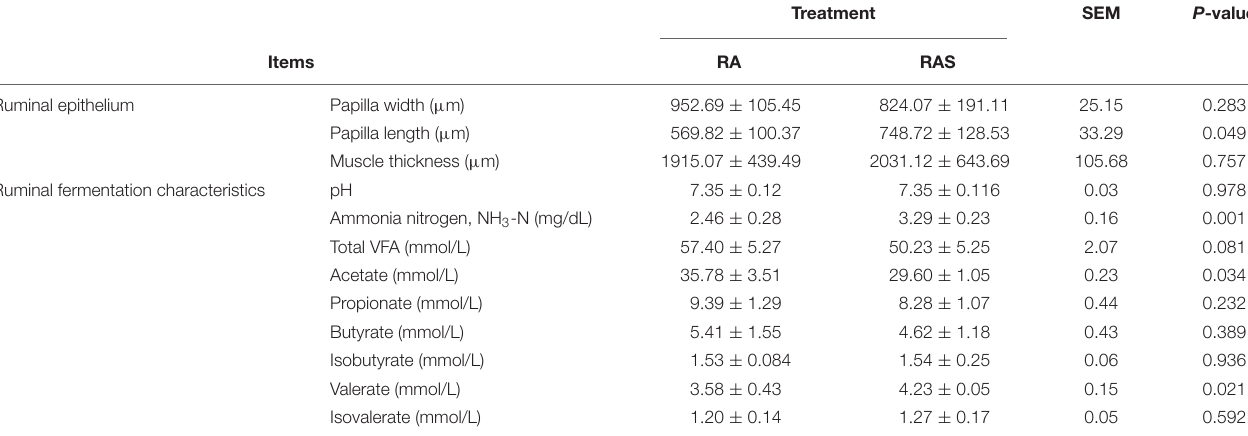
TABLE 3 | Effects of starter feeding on the ruminal fermentation parameters and ruminal epithelium development in yak calves.